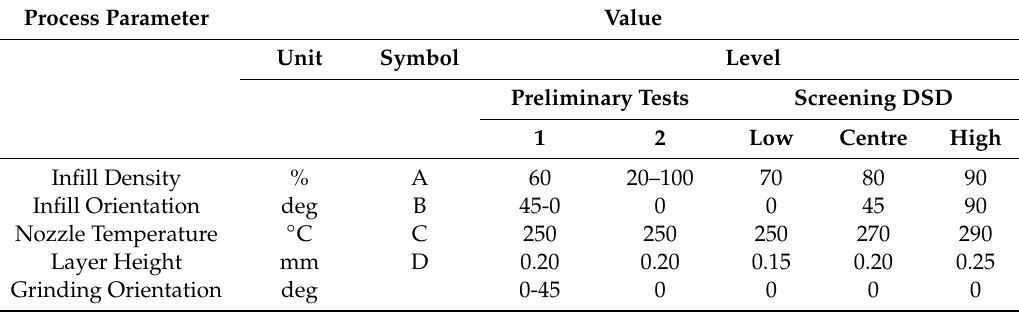
Table 1. Selected process parameters and respected levels for all experimental designs.